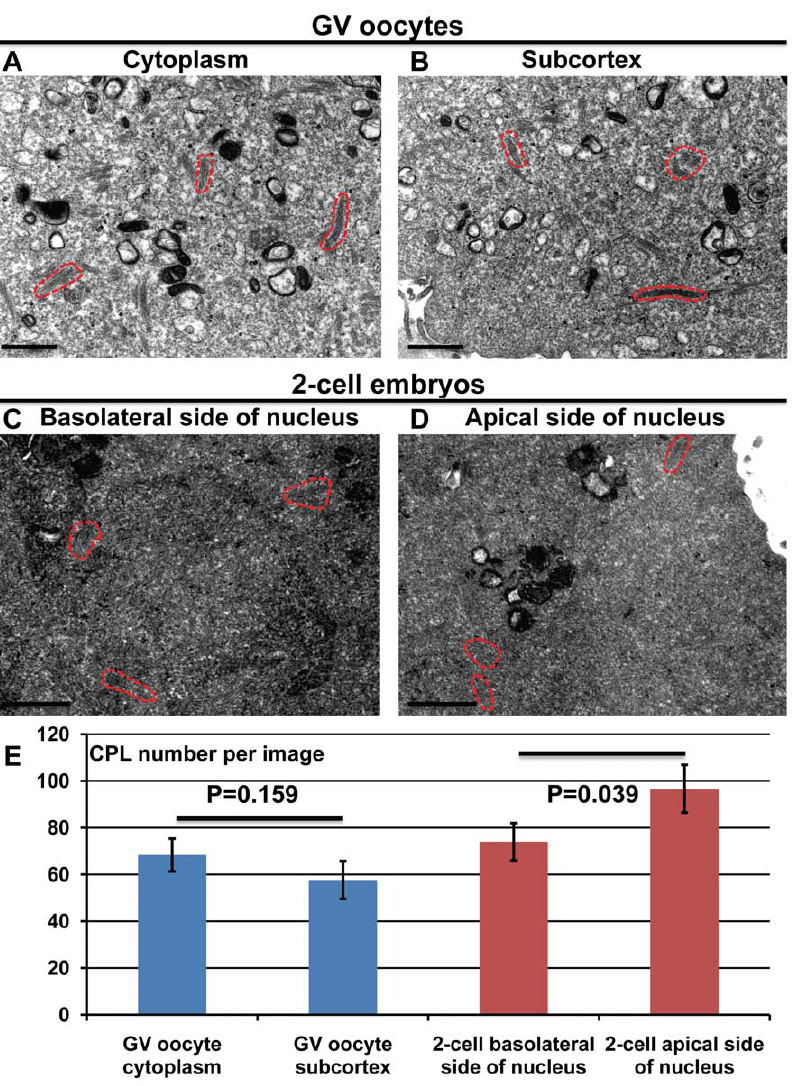
Figure 5. Quantification of CPLs in GV oocytes and two-cell embryos. GV oocytes (A and B) and two-cell embryos (C and D) were prepared for TEM. Representative images in the cytoplasm near the nucleus (A) or at the subcortex (B) of GV oocytes, and on either the basolateral (C) or apical (D) side of the nucleus in two-cell embryos. (E) The graph indicates the average number of CPLs per image in the four different aforementioned regions, as well as the two-tailed t -test P values. Representative CPLs are outined in dashed red lines. Bars, 1 m